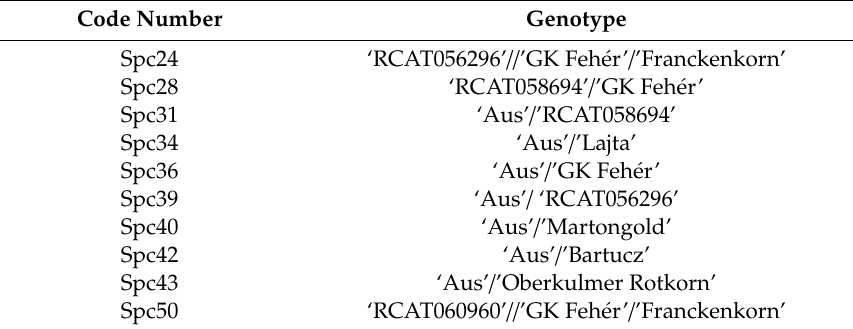
Table 13. The pedigree of F 1 combinations tested in vitro anther